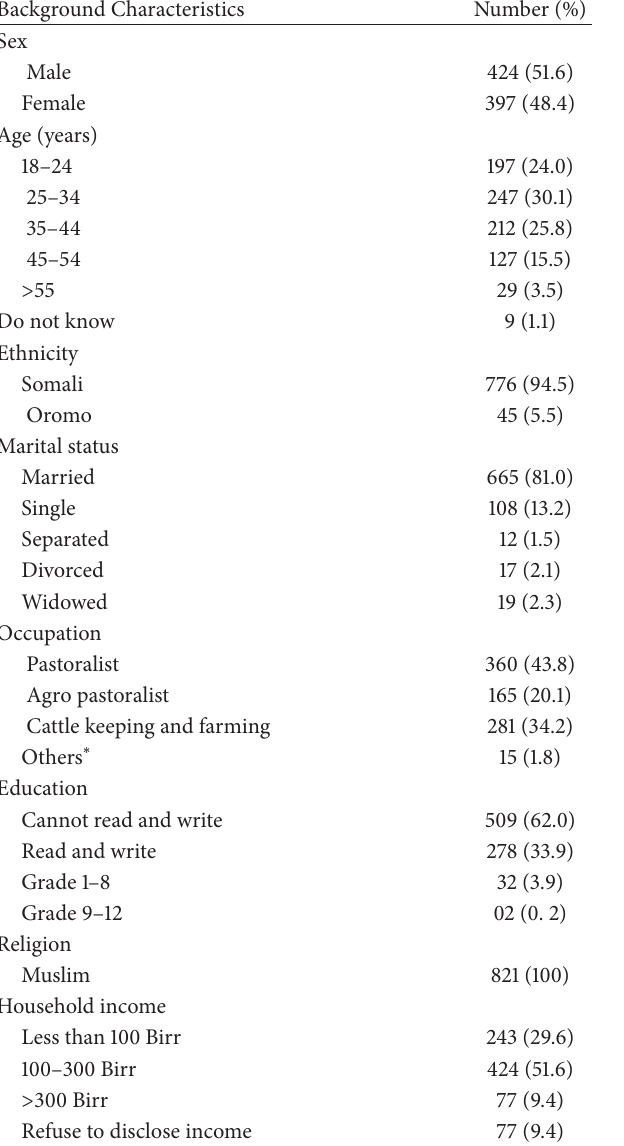
Table 2: Distributions of respondents by source of information on TB ( n = 821).